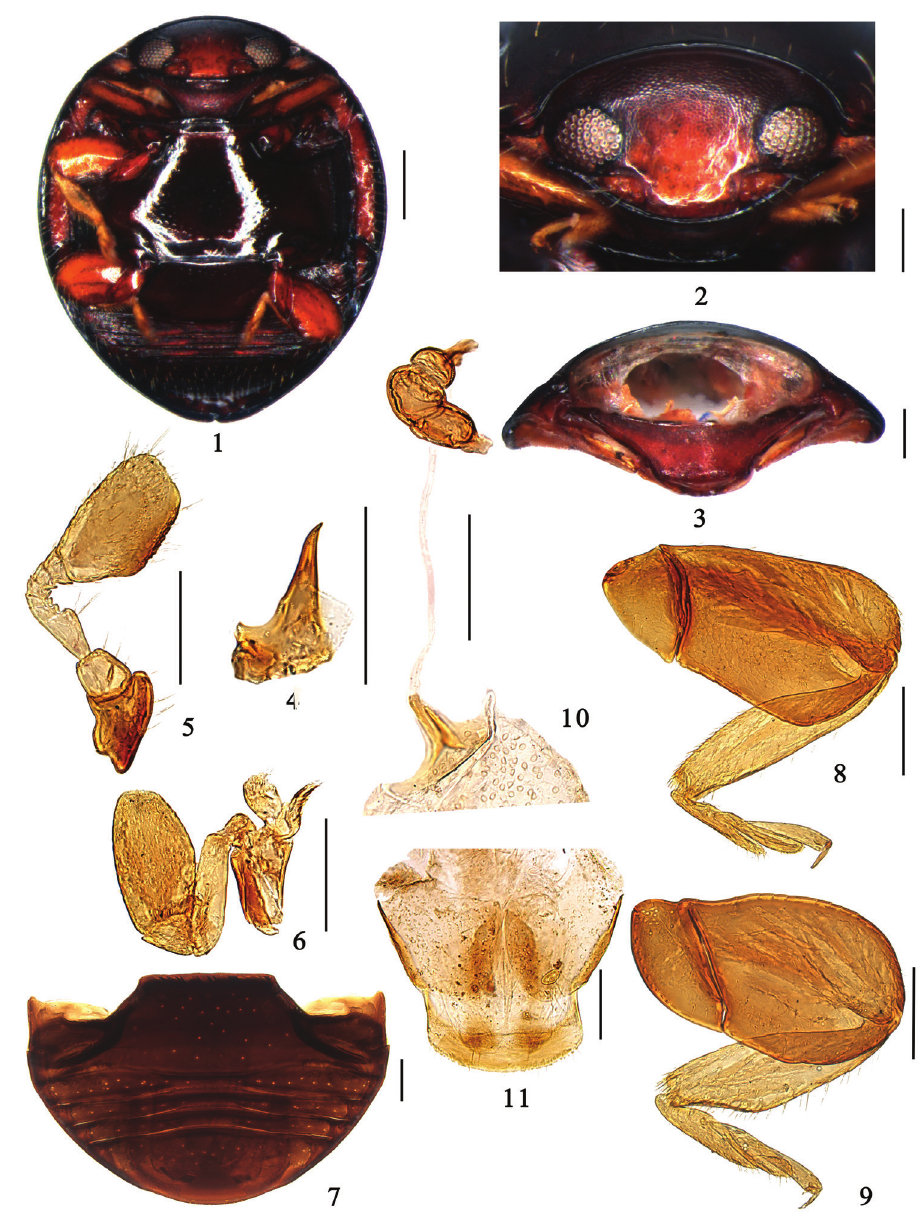
Figures 1–11. Microserangium dactylicum Wang & Ren, sp. n. 1 ventral view 2 head frontal view 3 prothorax 4 mandible 5 antenna 6 maxilla 7 abdomen 8 fore leg 9 hind leg 10–11 female genitalia. Scale bars: 0.1mm. antennomere 2 globular and smaller than 1, antennomere 3 strongly triangular; club, oval and flat with apex angulate (Fig. 5). Terminal maxillary palpomere always longer than wide, barrel-shaped, truncate at apex (Fig.